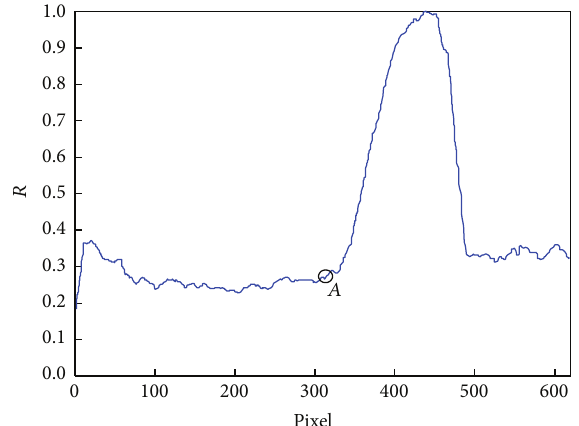
Figure 9: Picture for statistical results of jet frontier.